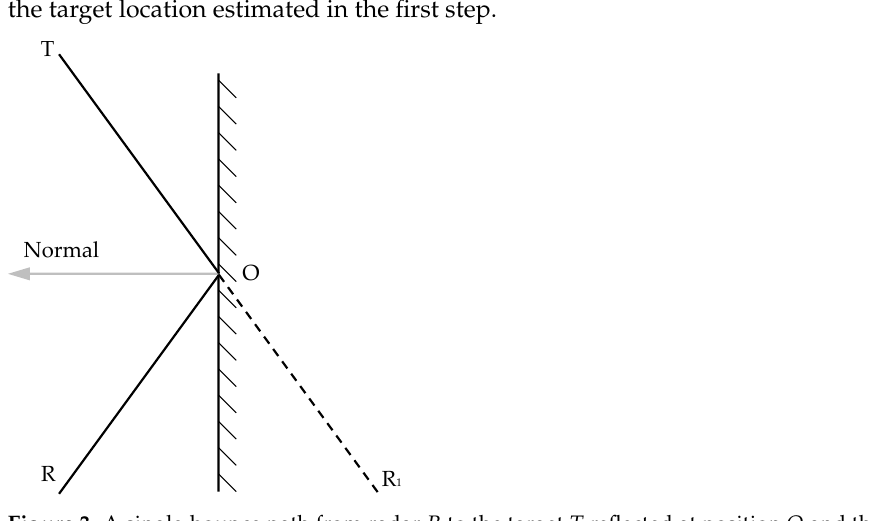
Figure 3. A single-bounce path from radar R to the target T reflected at position O and the equivalent path from virtual radar R 1 to the target